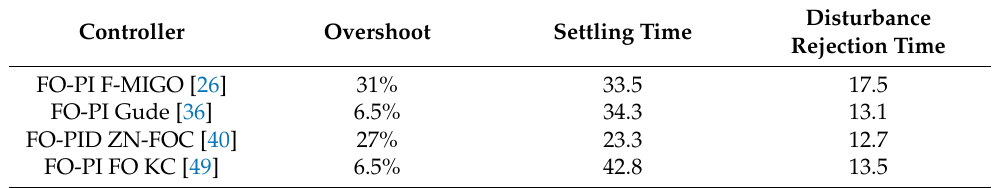
Table 5. Closed-loop results obtained with the FO-PID controller for the higher order process. Controller